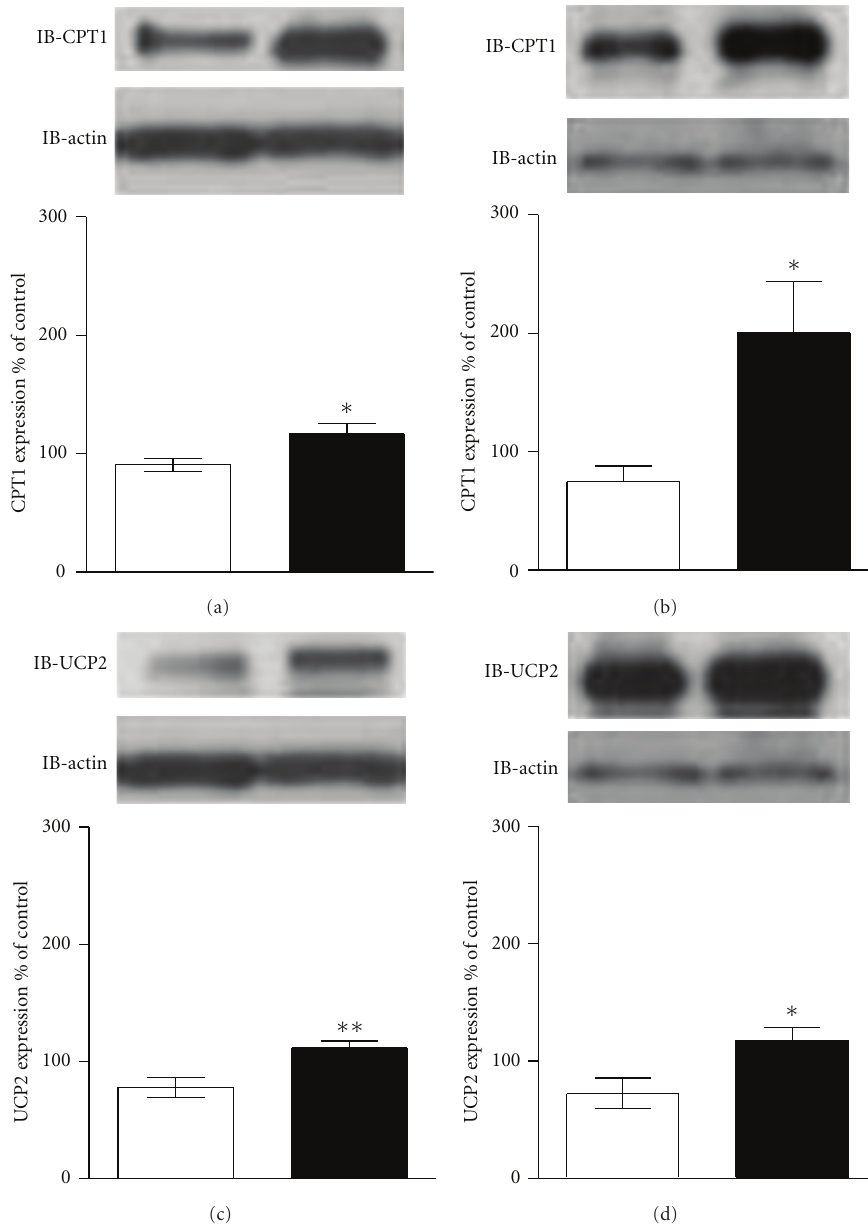
Figure 2: Western blotting analysis of CPT1 and UCP2 contents of (a, c) lymphocytes and (b, d) cardiomyocytes obtained from control group (white bars) and 24 h-fasted group (black bars). Graphics show the relative density of proteins levels which were normalized to those of Actin. Values represent mean ± SEM. Asterisks denote significant di ff erence ( ∗ P < 0 . 05 and ∗∗ P < 0 . 01) from values for control group as calculated by Student’s t